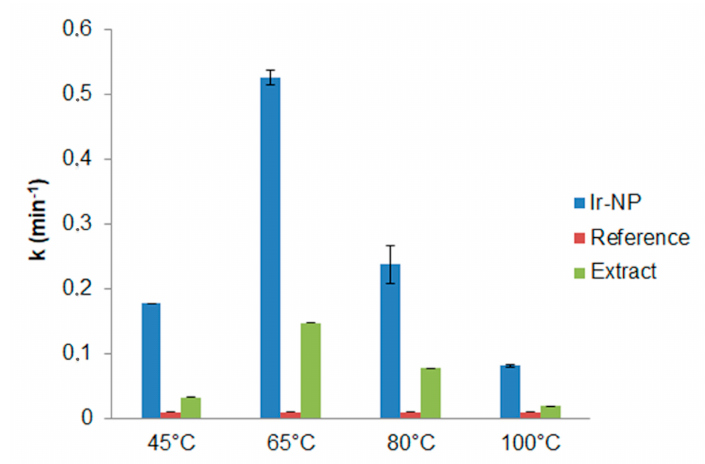
Figure 8. Constant rates (k) comparison between Ir-NPs, reference, and extracts.